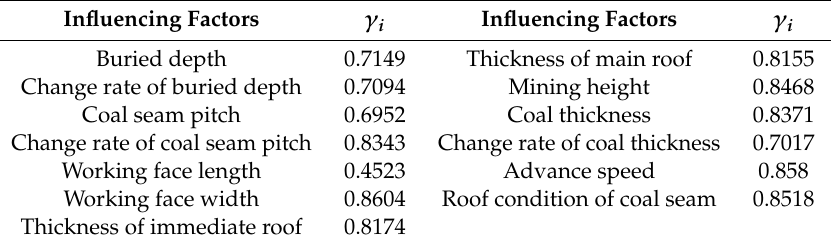
Table 2. The correlations of the first weighting and related influencing